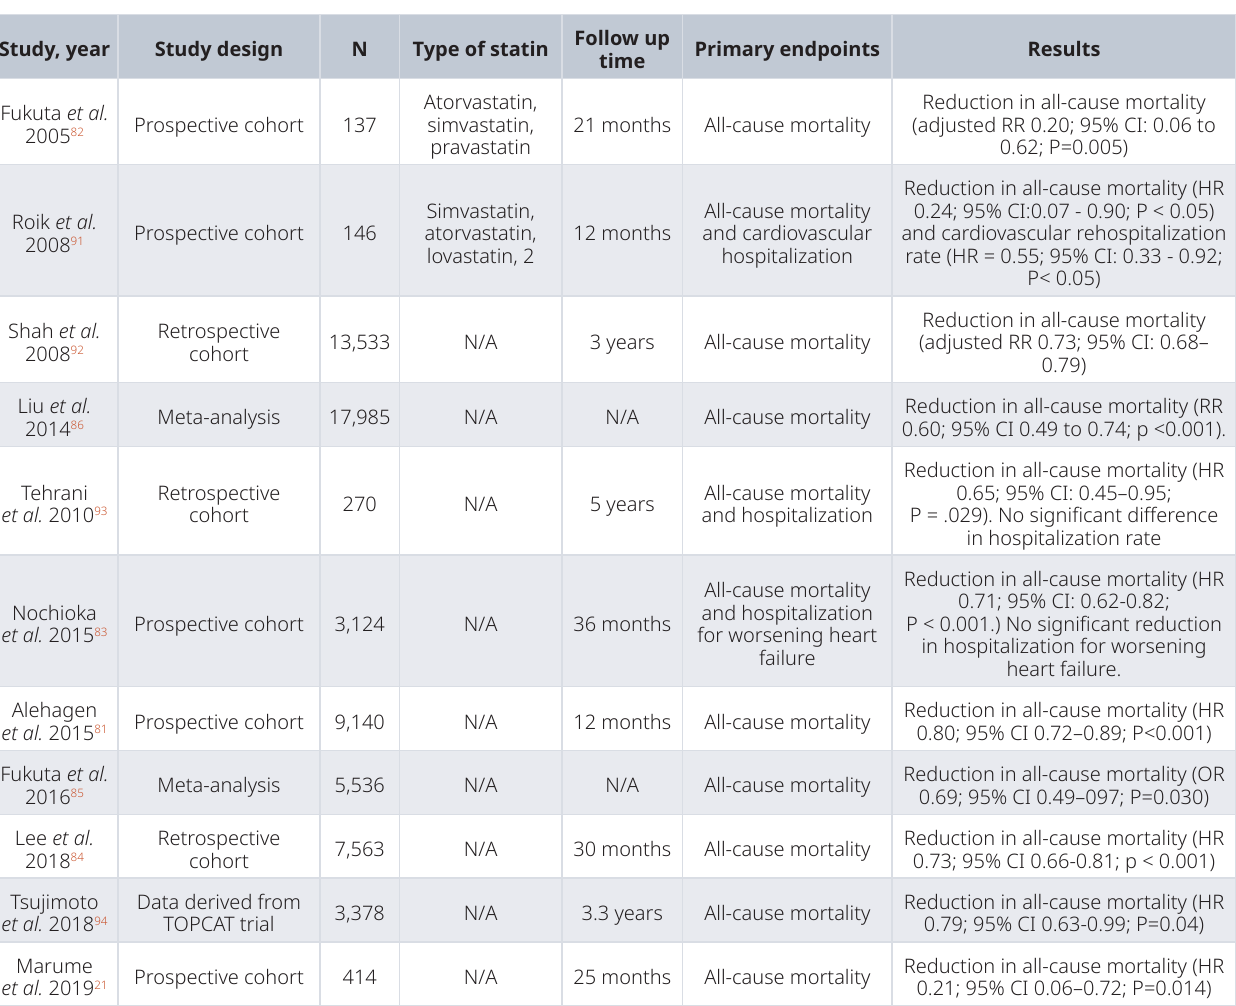
Table 3. Relevant clinical studies with the primary objective of determining the effects of statins in patients with heart failure with preserved ejection fraction.